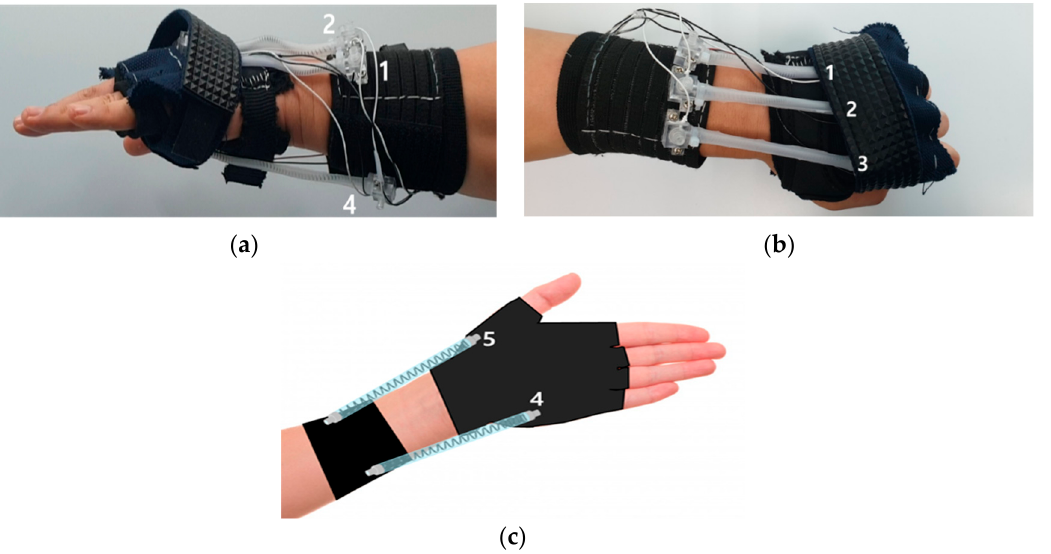
Figure 7. Wearable Robot for wrist ( a ) side view, ( b ) top view, ( c ) bottom view.